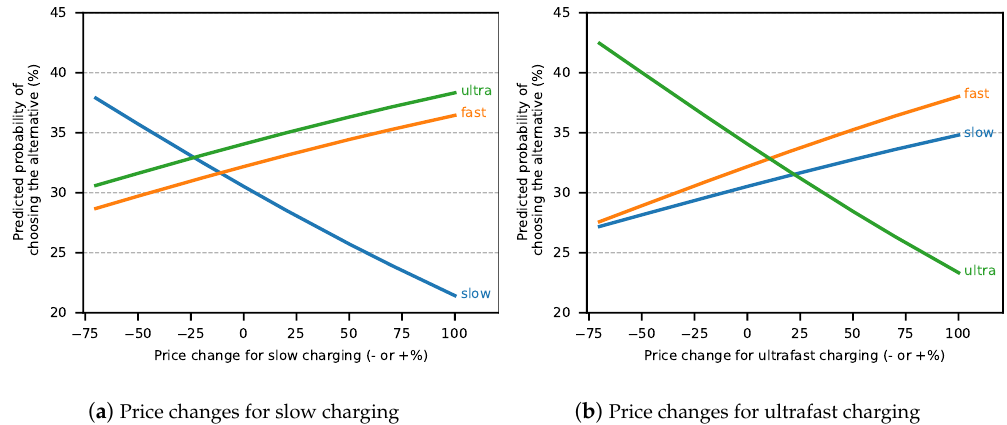
Figure 5. Predicted probabilities for scenarios with price changes per